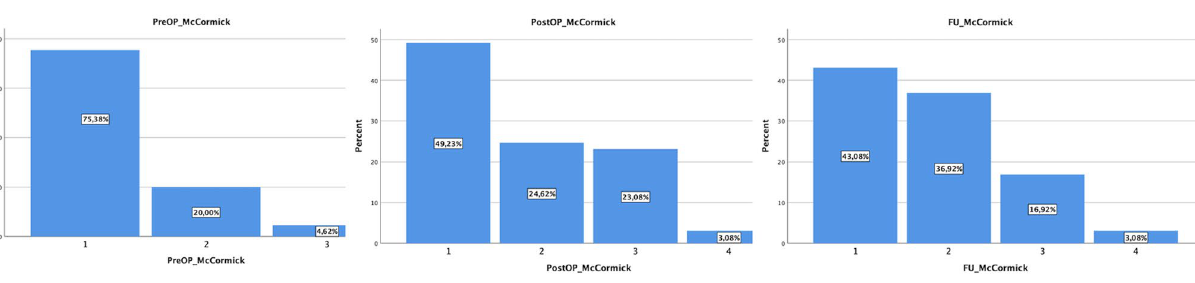
Figure 2. Preoperative, postoperative and follow-up McCormick grades describing clinical state and functional